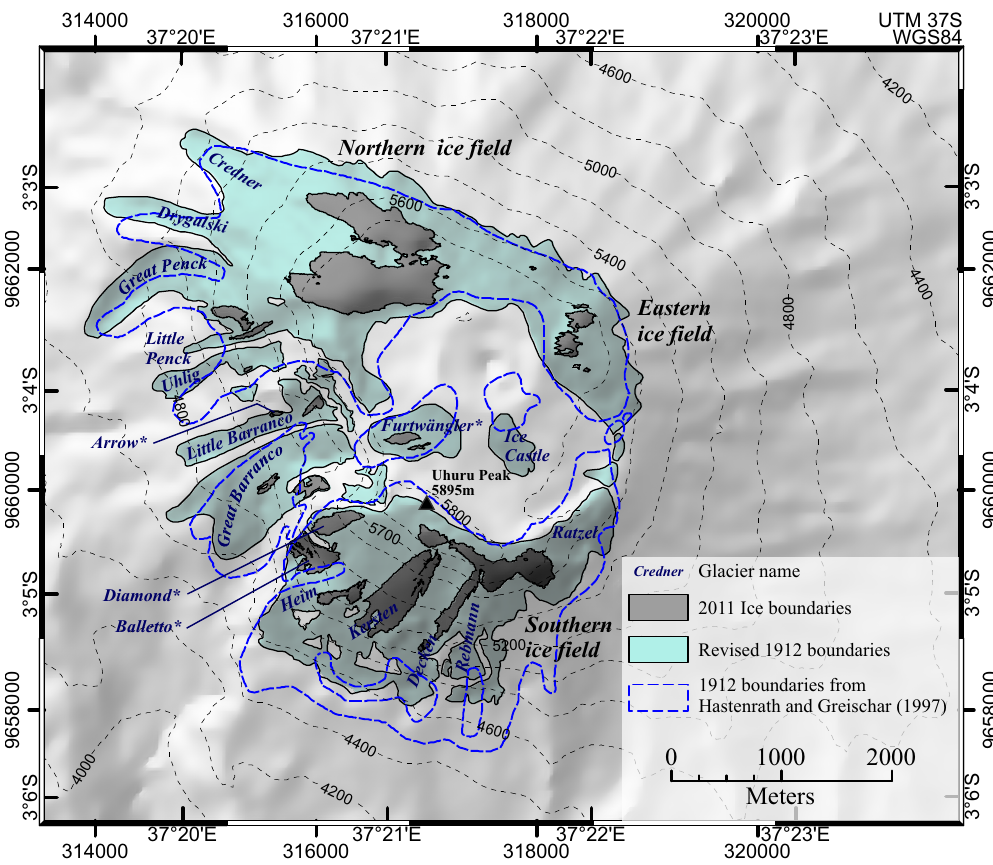
Fig. 1. Glacier extent on Kilimanjaro in 1912 and 2011. Glacier names with an asterisk do not appear in Klute (1920) and are described in the text. The interpretation of the glacier extent for 1912 as defined by Hastenrath and Greischar (1997) is shown as a dashed line (blue) for comparative purposes. The nomenclature for each glacier used by Klute (1920) is given, while the names of four glaciers introduced after this time are indicated using ∗